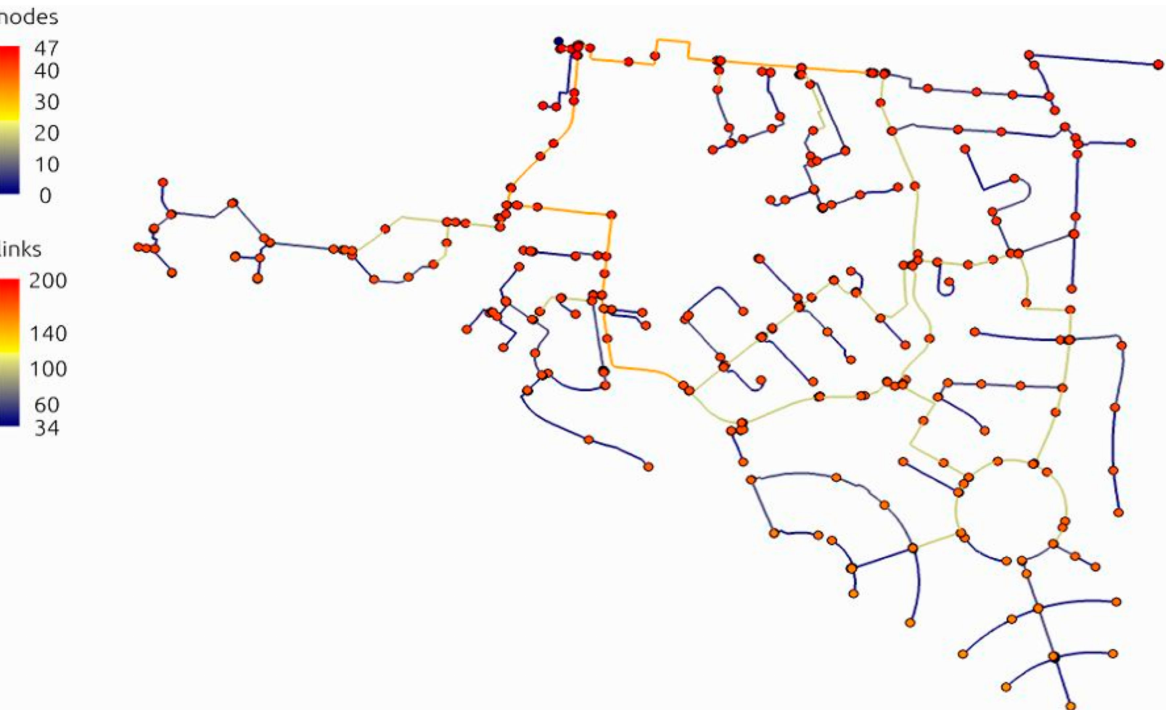
Figure 3. Pipe diameters of the infrastructure currently installed. The different colors indicate the diameter for each pipe (links in mm) and the pressure at the nodes (nodes in m) for the deterministic water demand in the hydraulic model (PF = 2.77). The minimum pressure in the network is 34.15